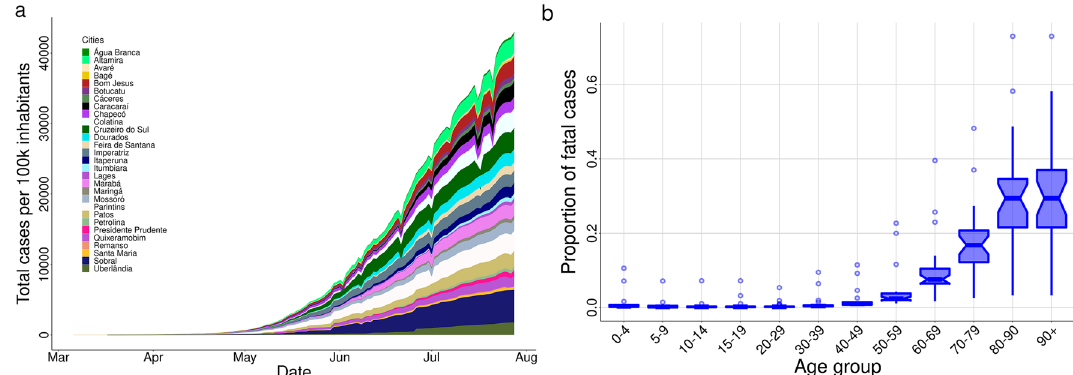
Figure 7. In ( a ), temporal evolution of the cumulative number of reported cases in each municipality; in ( b ), the boxplot of the proportion of reported fatal cases for different age groups in twenty Brazilian states enrolled in the study through their